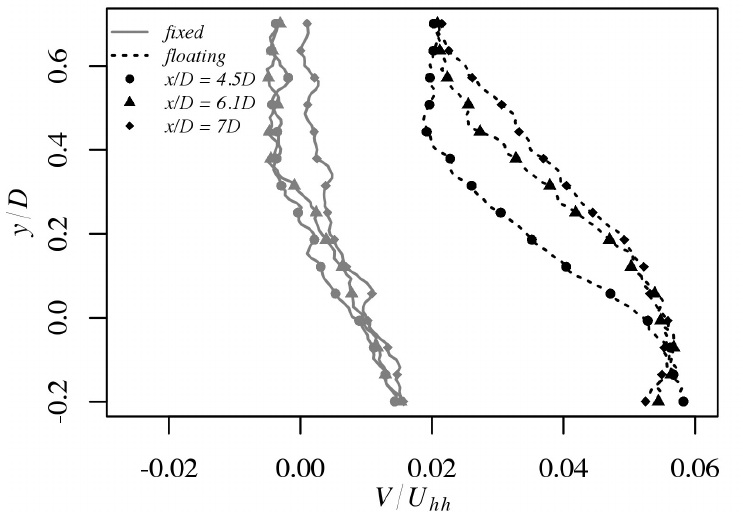
Figure 8. Far wake profiles of V/U 4.5 D , 6.1 D and 7 D